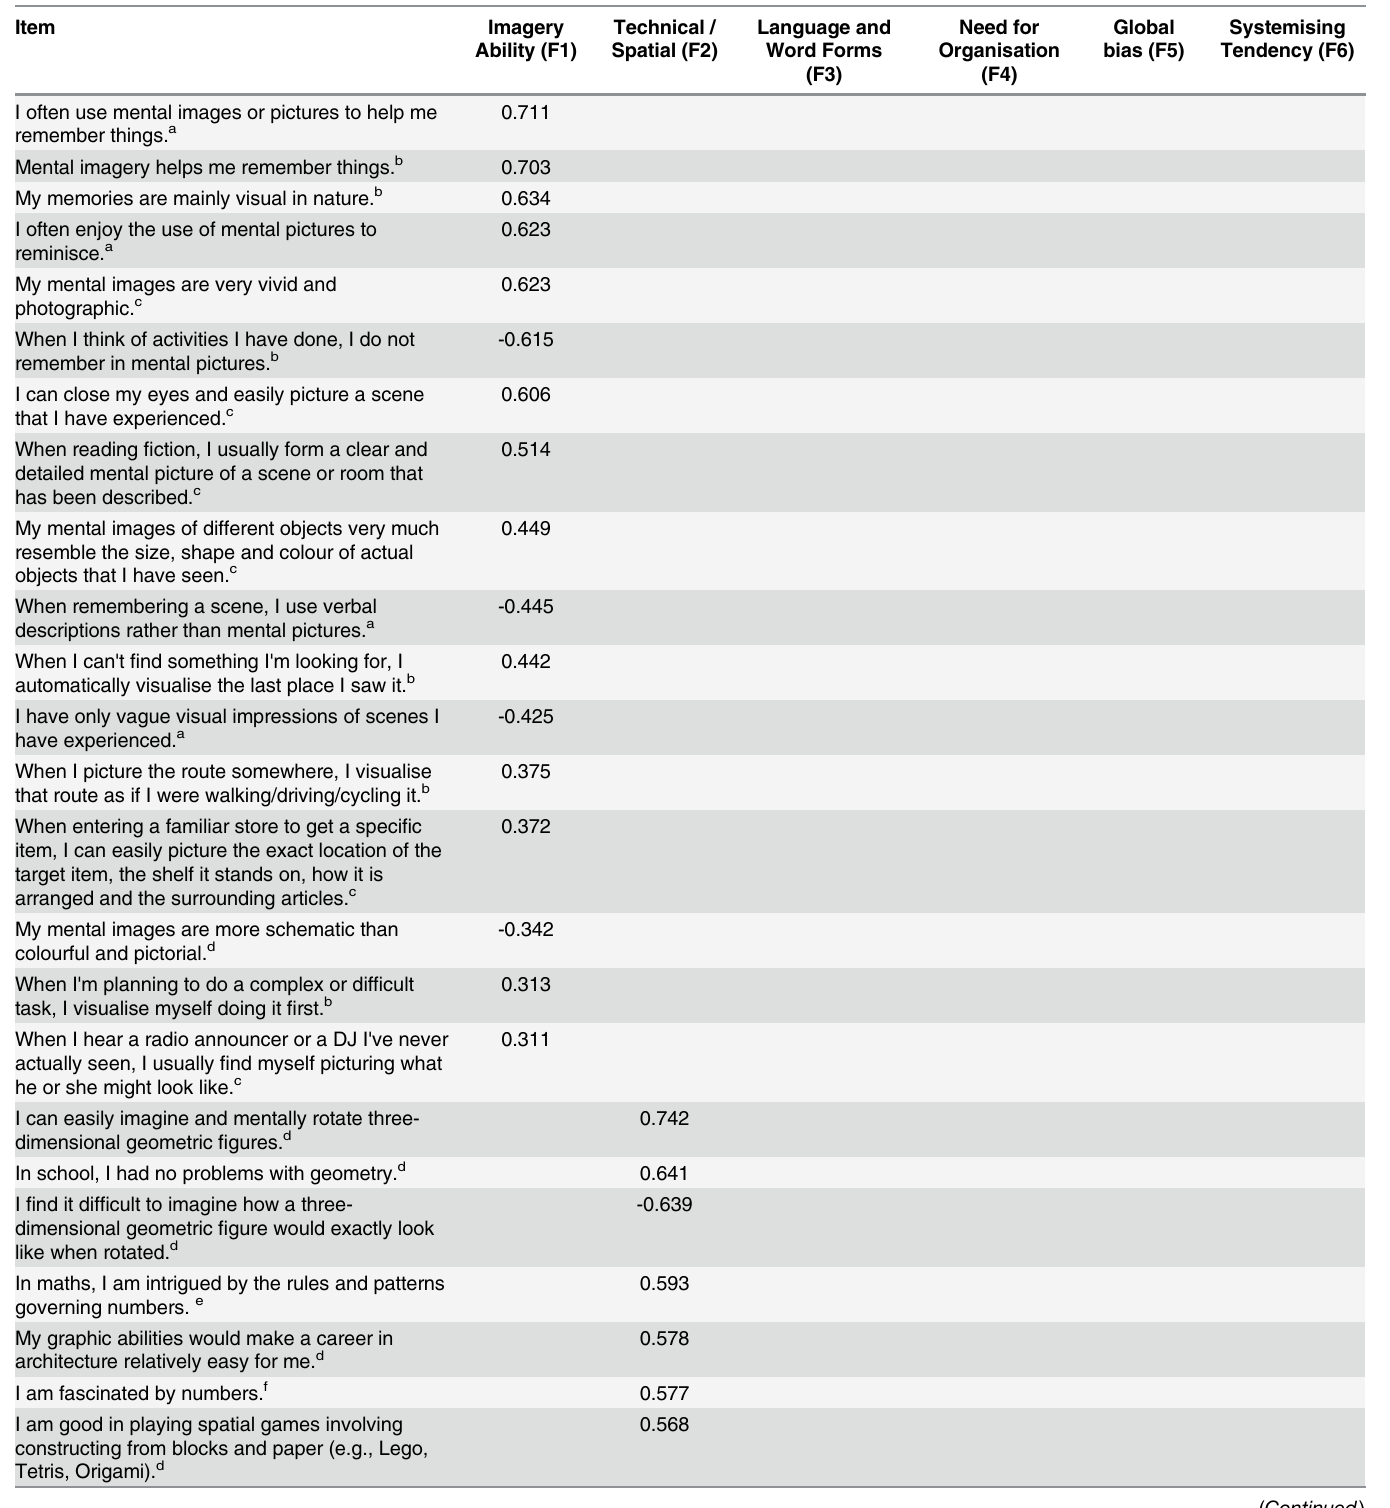
Table 1. Rotated factor matrix of factor loadings for the final sixty items of the